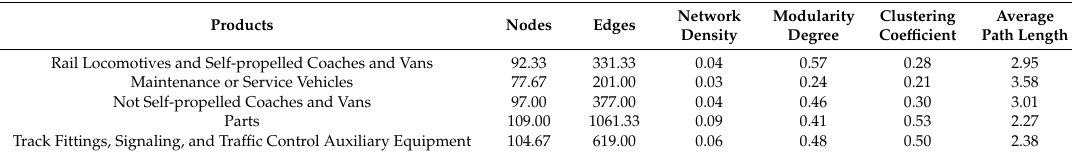
Table 5. Network-level indices of five categories of products in the BRI region (means of 3 phases). Products Nodes Edges Network Density Modularity Degree Clustering Coe ffi cient Average Path Length Rail Locomotives and Self-propelled Coaches and